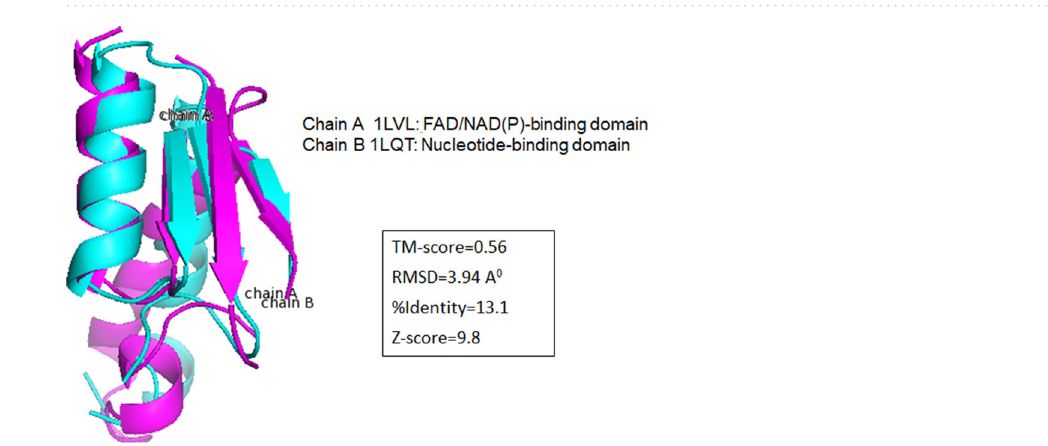
Figure 6. Comparative performance of PSI-BLAST, Master Blaster and HHblits for different structural classes Alpha (a), Beta (b), Alpha and Beta (a/b) and Alpha and Beta (a + b).